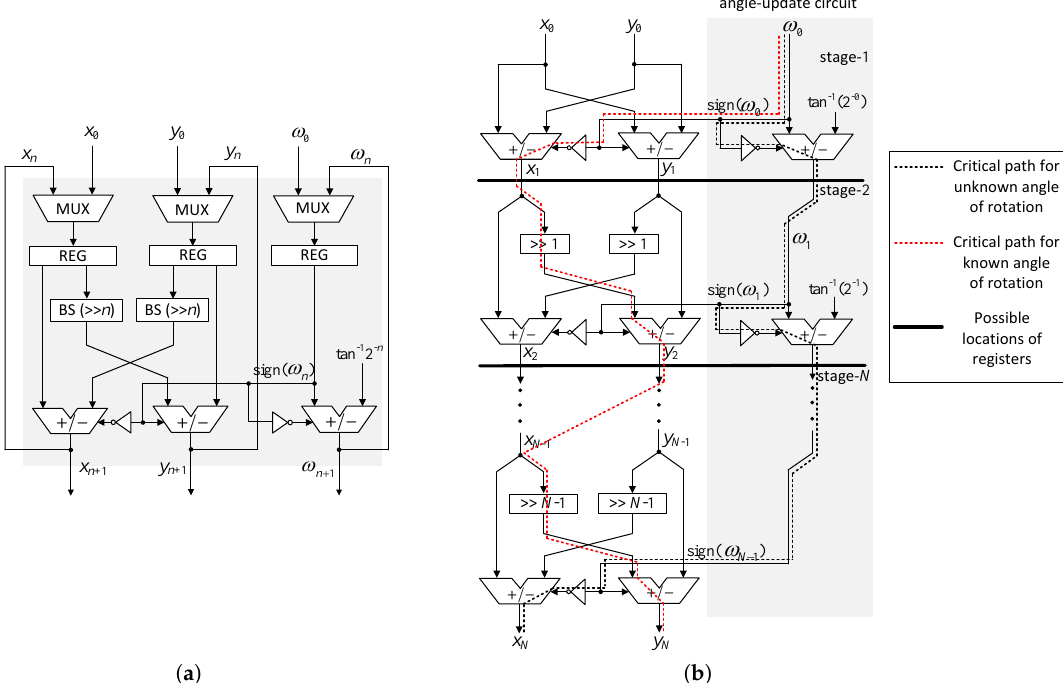
Figure 1. ( a ) A conventional recursive coordinate rotation digital computer (CORDIC) circuit. BS: barrel shifter; REG: register. ( b ) N -stage non-recursive cascaded